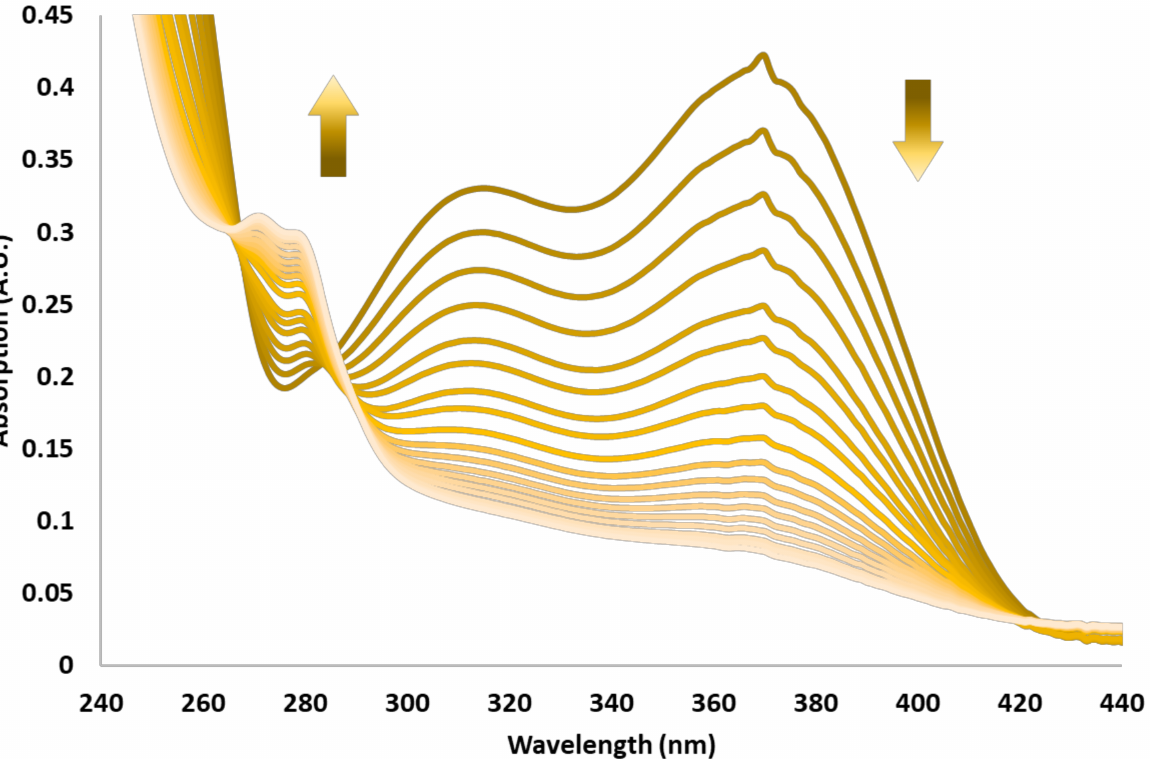
Figure 6. UV-vis spectra of DHP-OH in Tris-HCl (pH 6.0) (50 µ M) after addition of Au 3+ (100 µ M) over a period of 5–90